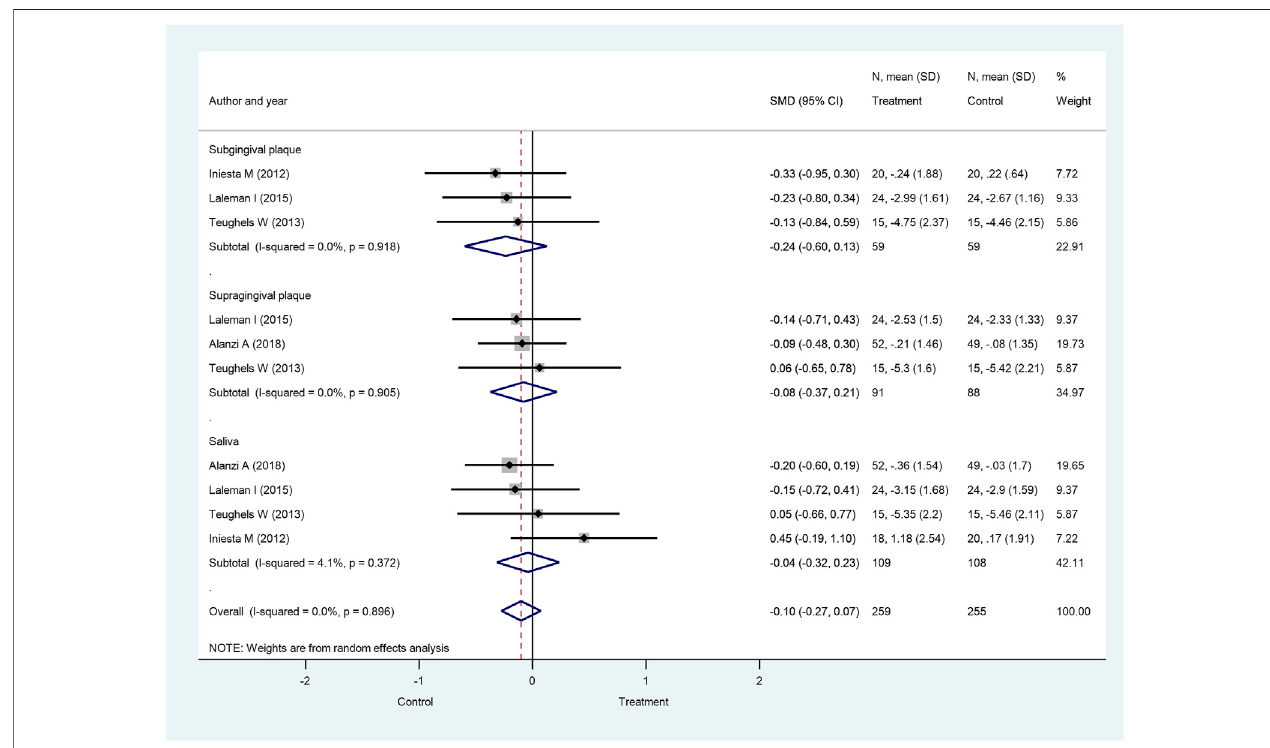
FIGURE 7 | Forest plot analysis of the change in Fusobacterium nucleatum at 4 weeks. The overall result presented no signi fi cant difference of bacterial decrease when both treatment and control groups were compared (SMD: − 0.10; 95% CI: − 0.27 – 0.07; p (cid:2) 0.256).